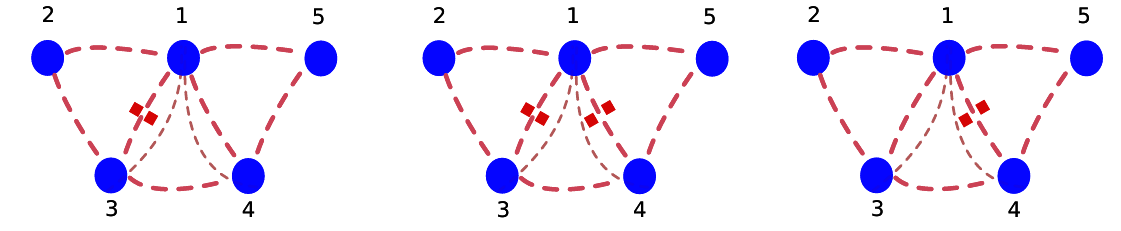
Figure 5 . One of four possible tessellations of the pentagon skeleton diagram by six hexagons.